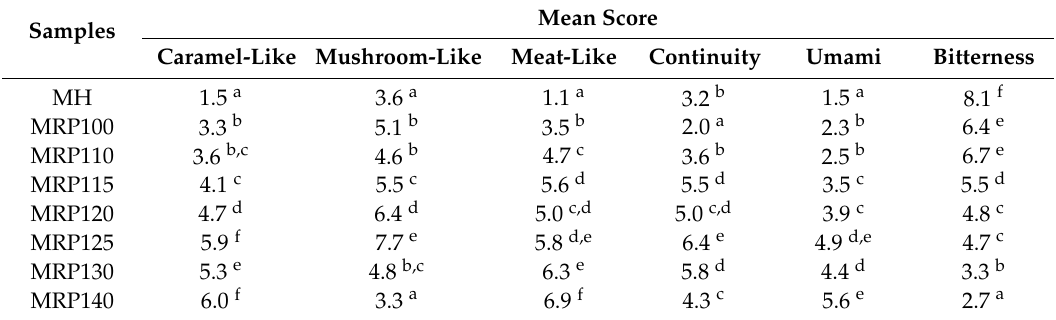
Table 3. The mean intensity values of six attributes for MH and seven MRPs samples in sensory